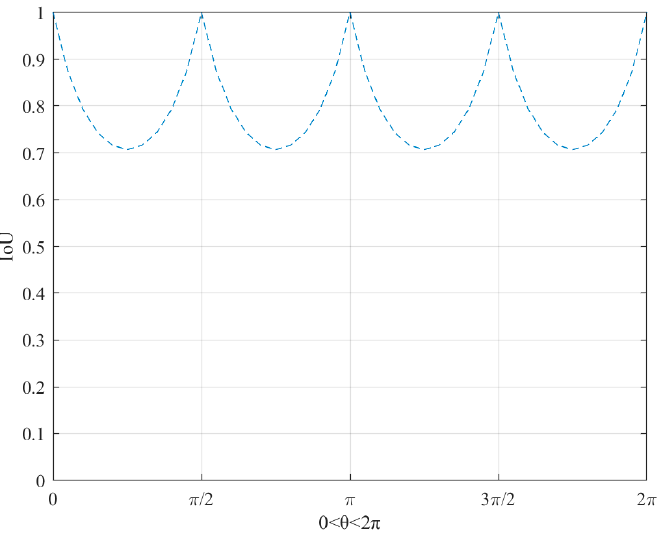
Figure 15. The variation curve of IoU.